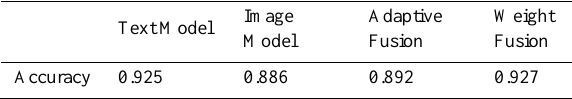
Table 9. Weight model performance (λ = 0.02) on test